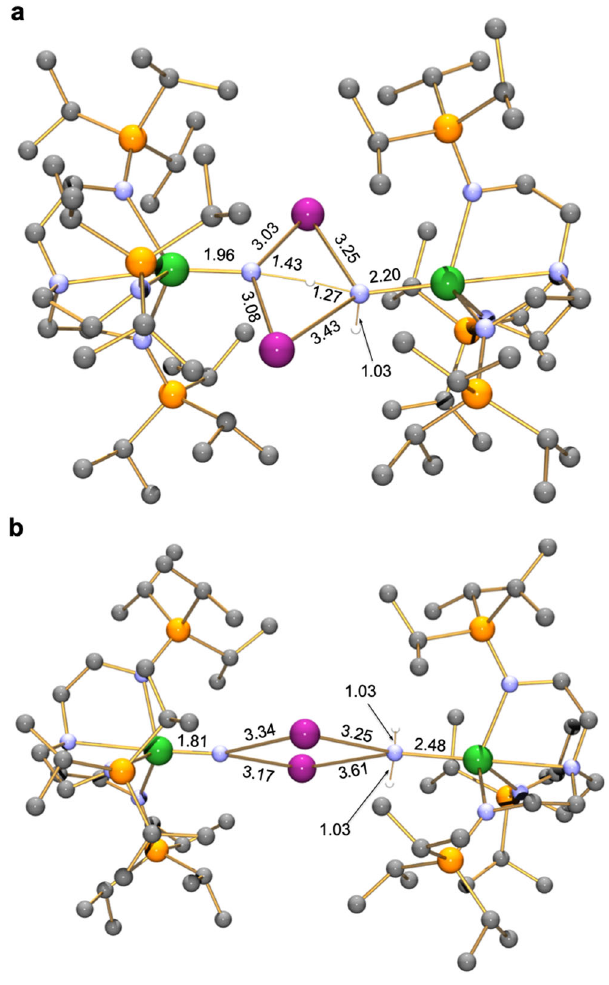
Fig. 8 Computed structures, with C – H hydrogen atoms omitted for clarity, of the key transition state and intermediate in the disproportionation of 2Cs to 4Cs/1/Cs + (C 6 H 6 ) − (cid:129) . a The structure of Cs-TS-dis with key bond distances (Å). b The structure of Cs-product-dis with key bond distances (Å). Key: uranium, green; caesium, purple; carbon, grey; hydrogen, white; nitrogen, blue; silicon,